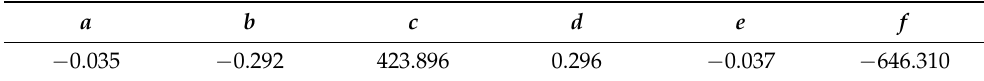
Table 4. Six parameters of affine transformation.